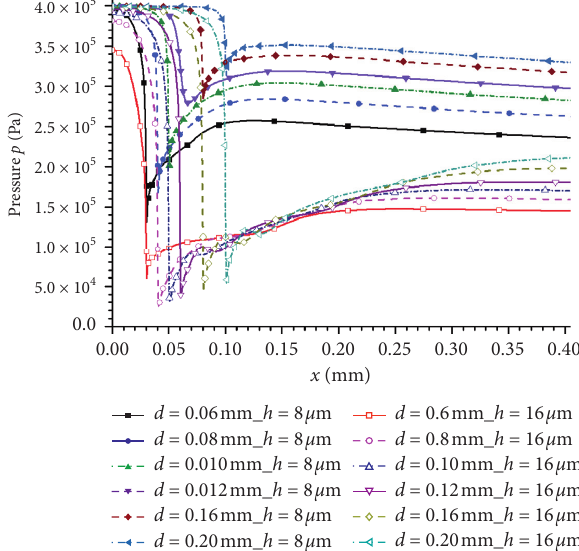
Figure 13: Curves D 1 of the pressure of the gas film at different d